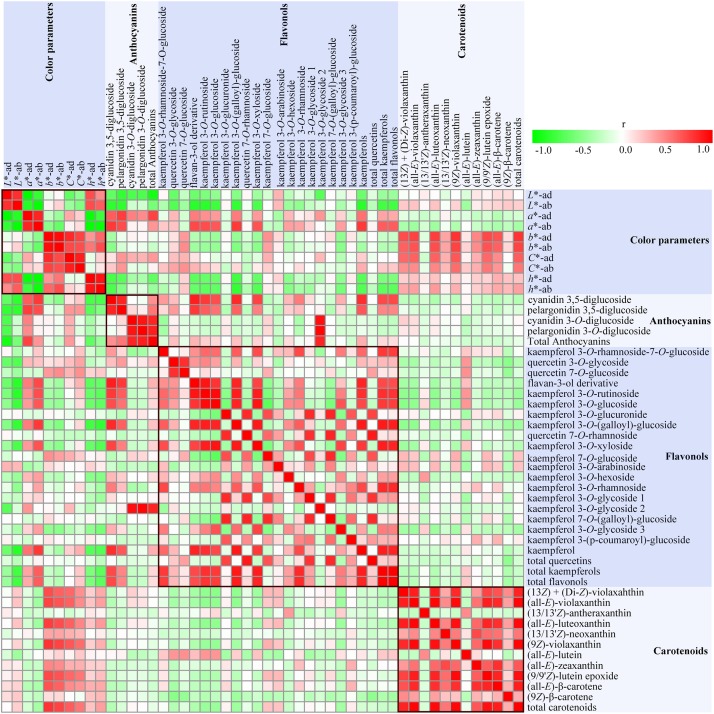
A heat map of correlation matrix of color parameters and 47 compounds from petals of six rose cultivars at seven developing stages. Each square indicates Pearson’s correlation coefficient for a pair of data, and the intensity of red and gree colors in the heat map indicates the level of positive and negative correlation, respectively.